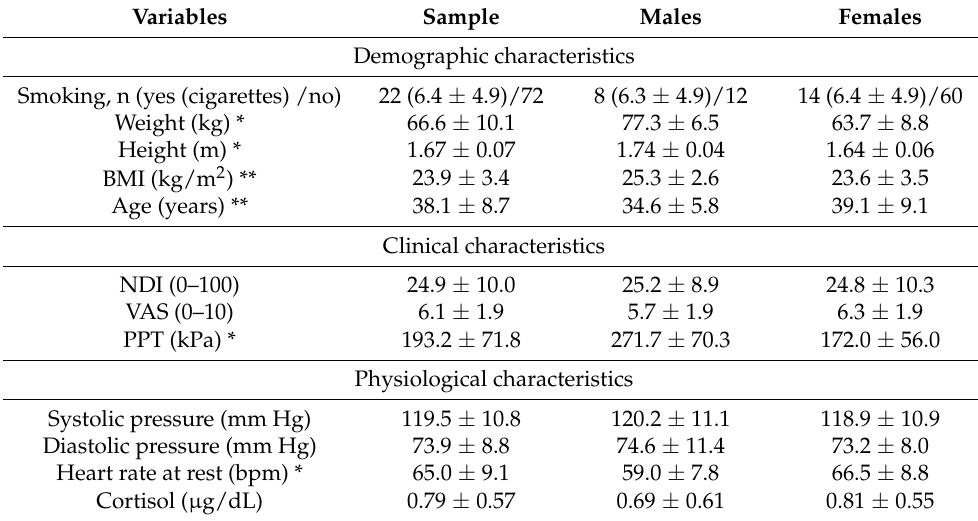
Table 1. Baseline characteristics of the participants. Variables Sample Males Females Demographic